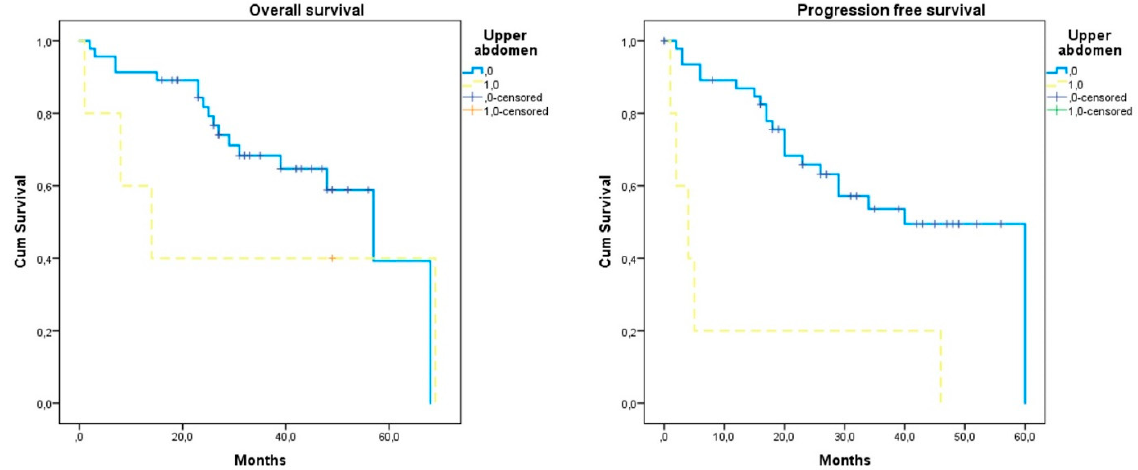
Figure 2. Kaplan–Meier plot of recurrence-free survival and overall survival according to the presence of upper abdominal metastases. Yellow dotted line: declined chemotherapy; blue continuous line: received chemotherapy.